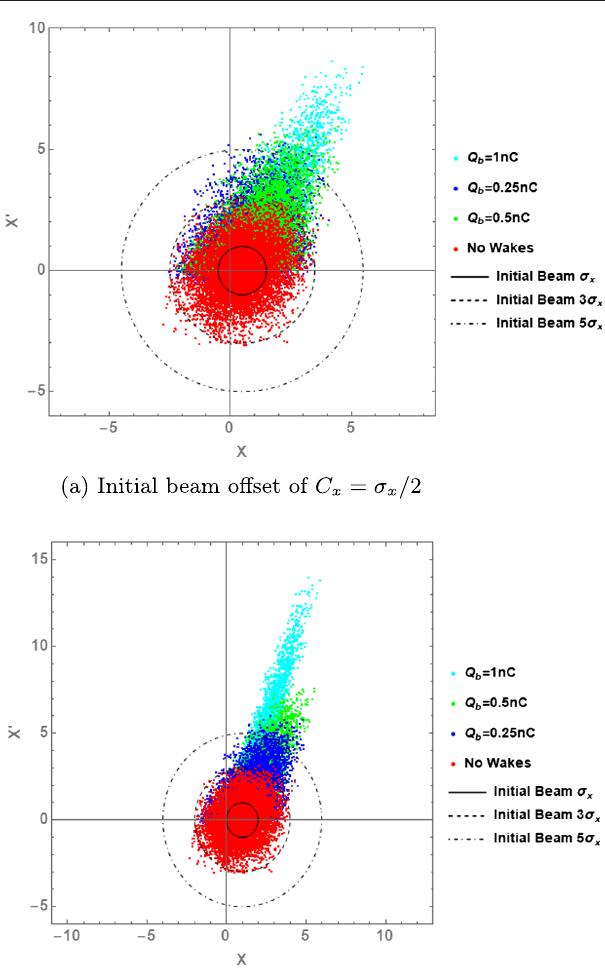
σ = 2 ; σ x ¼ x x (dashed x